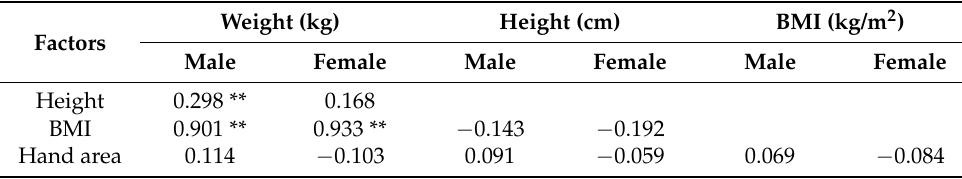
Table 3. The correlation between weight, height, BMI, and hand area.